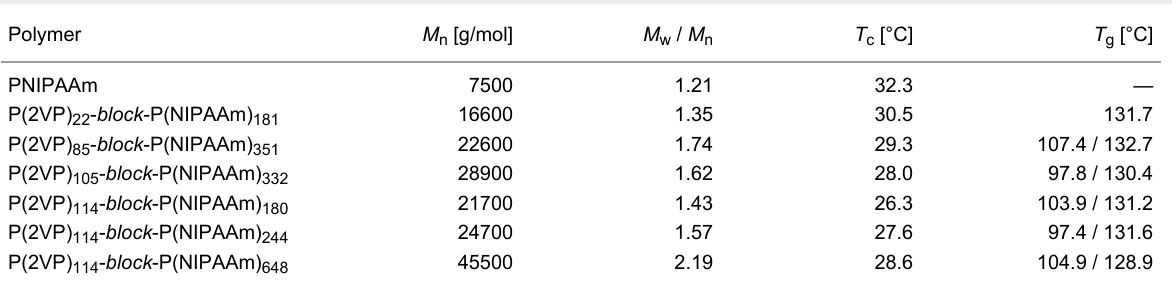
Table 2: Characterization of soluble linear P2VP- block -PNIPAAm copolymers created by NMRP.